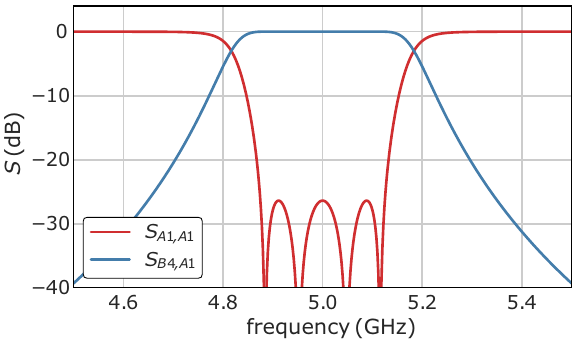
FIG. 14. (a) Coupling graph of a four-mode matched paramet- ric frequency converter, (b) circuit schematic. FIG. 15. S parameters of a matched parametric converter, cal- culated using Eq. (8) and the coupling matrix in Eq. (66). The frequency axis is referenced to the signal